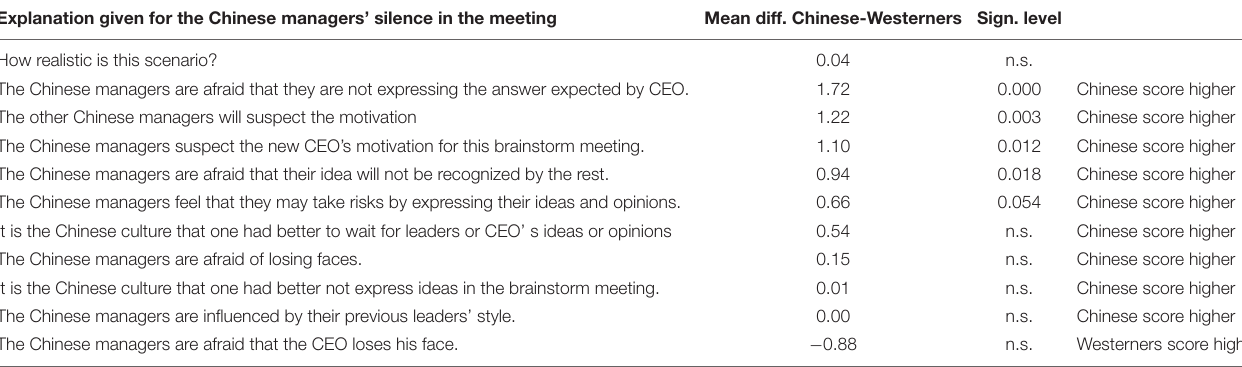
TABLE 6 | Reasons cited for why the managers keep quiet compared between the two ethnic groups.